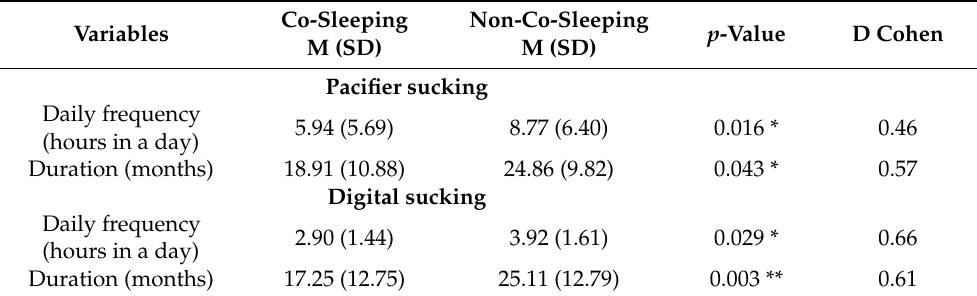
Table 2. Comparison of daily frequency and duration of oral habits (pacifier and digital sucking) in co-sleeping ( n = 130) and non-co-sleeping ( n = 91)